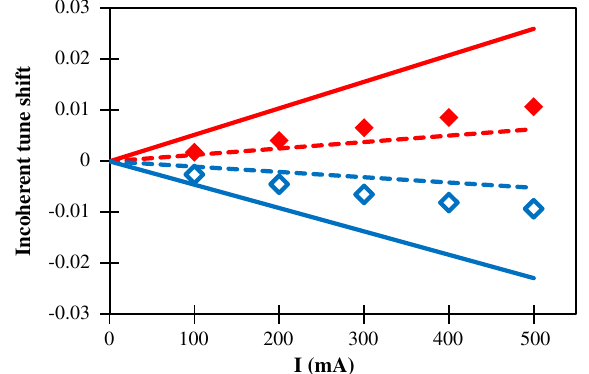
FIG. 2. Incoherent horizontal (red) and vertical (blue) tune shifts versus beam current in 4 = 4 filling: measured (diamond), model A (solid line), model B (dashed line). The precision on tune measured values is 1 × 10 − 4 . See the text for details of the